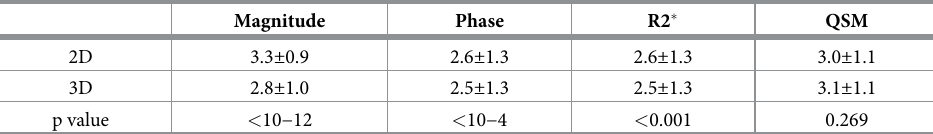
Table 3. Mean rating score for the visibility a of multiple sclerosis lesions.